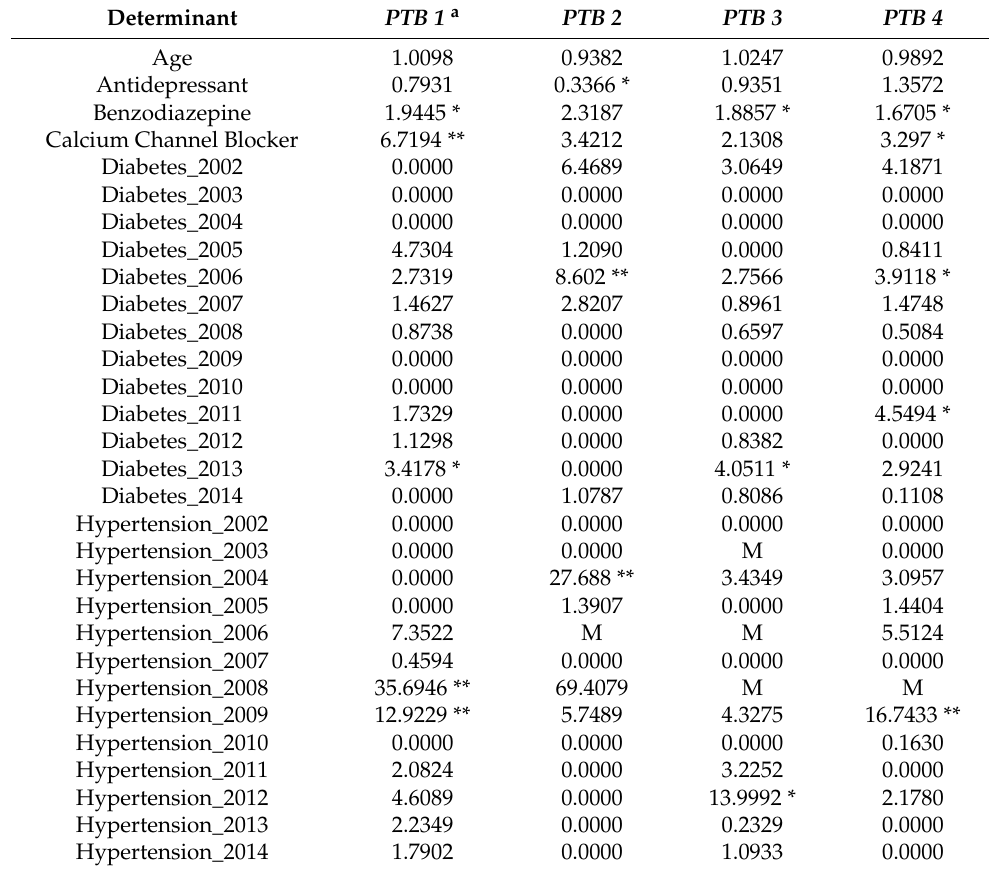
Table 2. Logistic Regression Results for Each Type of Preterm Birth: Ulcerative Colitis